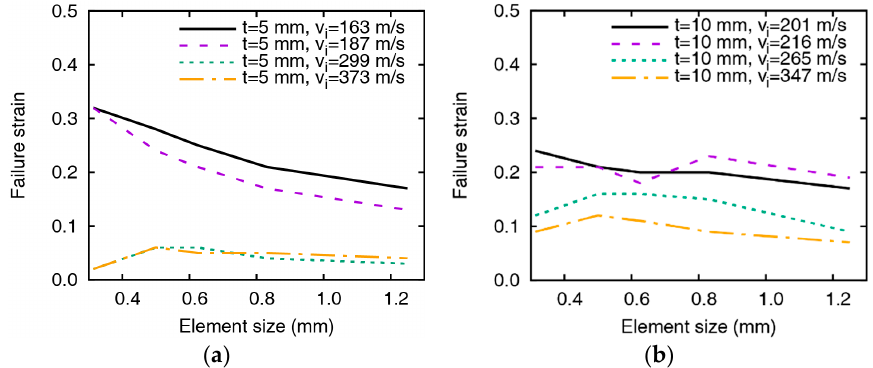
Figure 7. Failure strain by the change of element size. ( a ) 𝑡 (cid:2926)(cid:2922) = 5 mm and ( b ) 𝑡 (cid:2926)(cid:2922) = 10 mm.